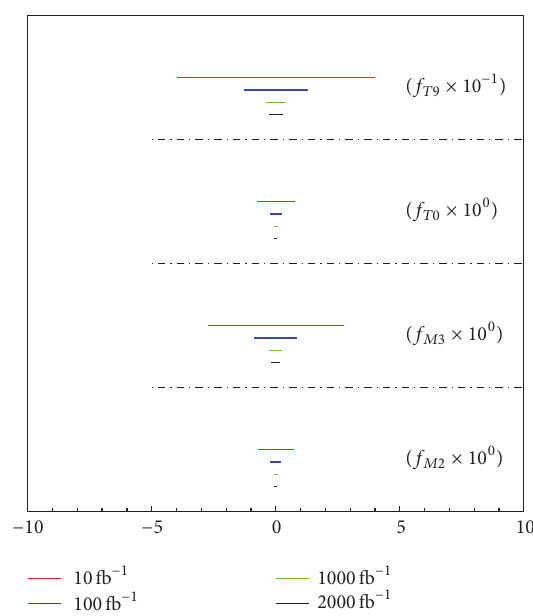
Figure 7: 95% CL sensitivity bounds of 𝑓 𝑀2 /Λ 4 , 𝑓 𝑀3 /Λ 4 , 𝑓 𝑇0 /Λ 4 , and 𝑓 𝑇9 /Λ 4 couplings for various values of integrated luminosities and √𝑠 = 3 TeV through the process 𝑒 + 𝑒 − → 𝑒 + 𝛾 ∗ 𝛾 ∗ 𝑒 − → 𝑒 + 𝑍𝑍𝑒 − .